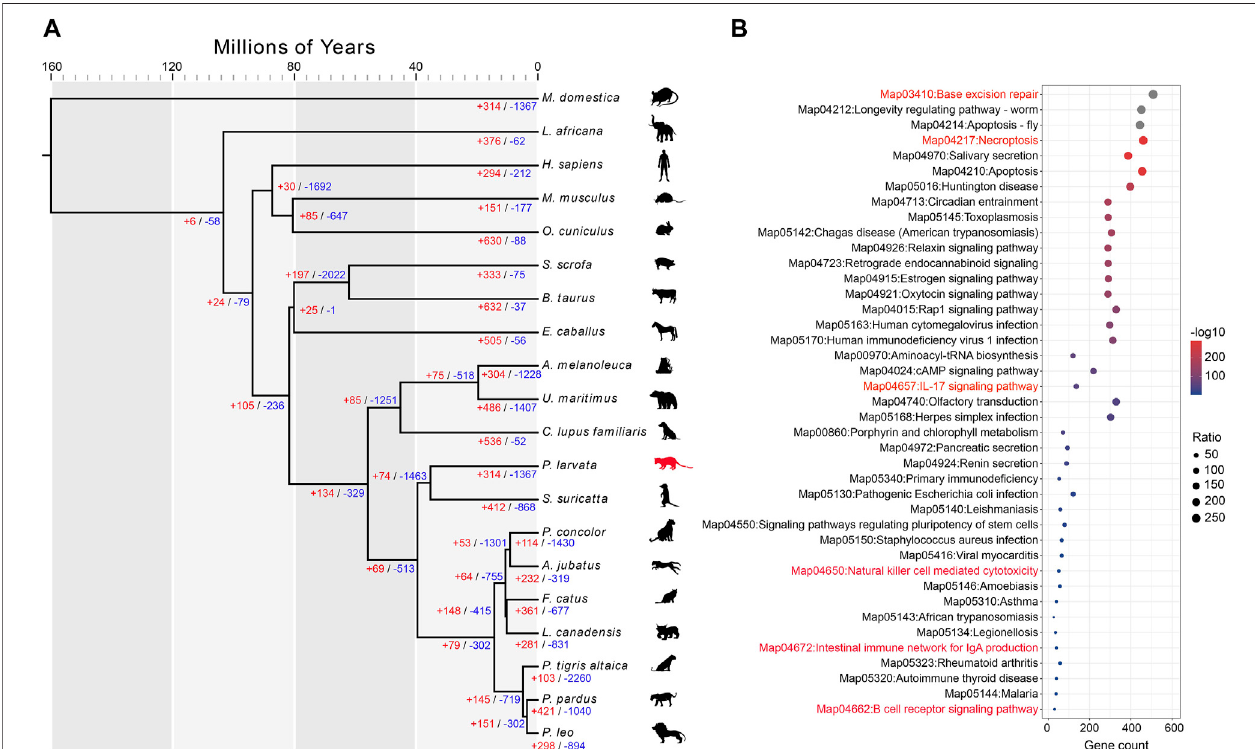
FIGURE 3 | Comparative genomic analysis and enrichment analysis of expanded gene families. (A) Divergence time estimated among 20 species. This tree topologywasgeneratedbyMCMCtree withCDSsequences. Thered andblue numbers indicate theexpandedand contractedgenefamiliesforeach node.Illustrations were created by adapting SMART (https://smart.servier.com) and Vecteezy (vecteezy.com) templates. (B) The signi fi cantly enriched KEGG pathways of 314 expanded gene families in the P. larvata genome compared with 19 other species.